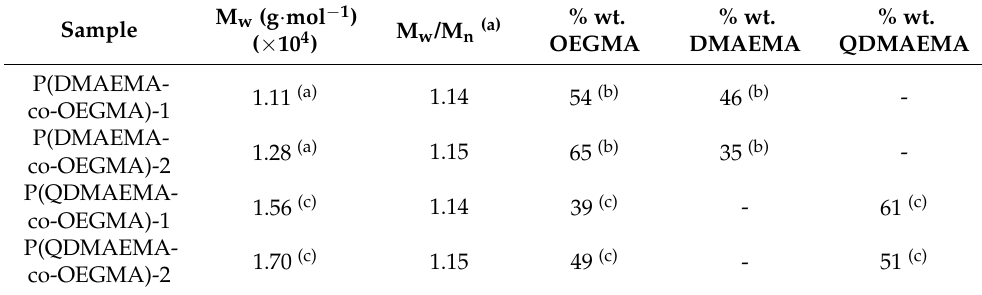
Table 1. Molecular characteristics of the synthesized copolymers.